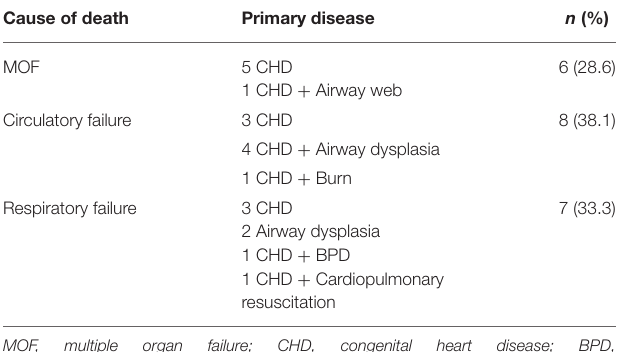
TABLE 7 | The cause of death and primary disease in children ( n = 21). Cause of